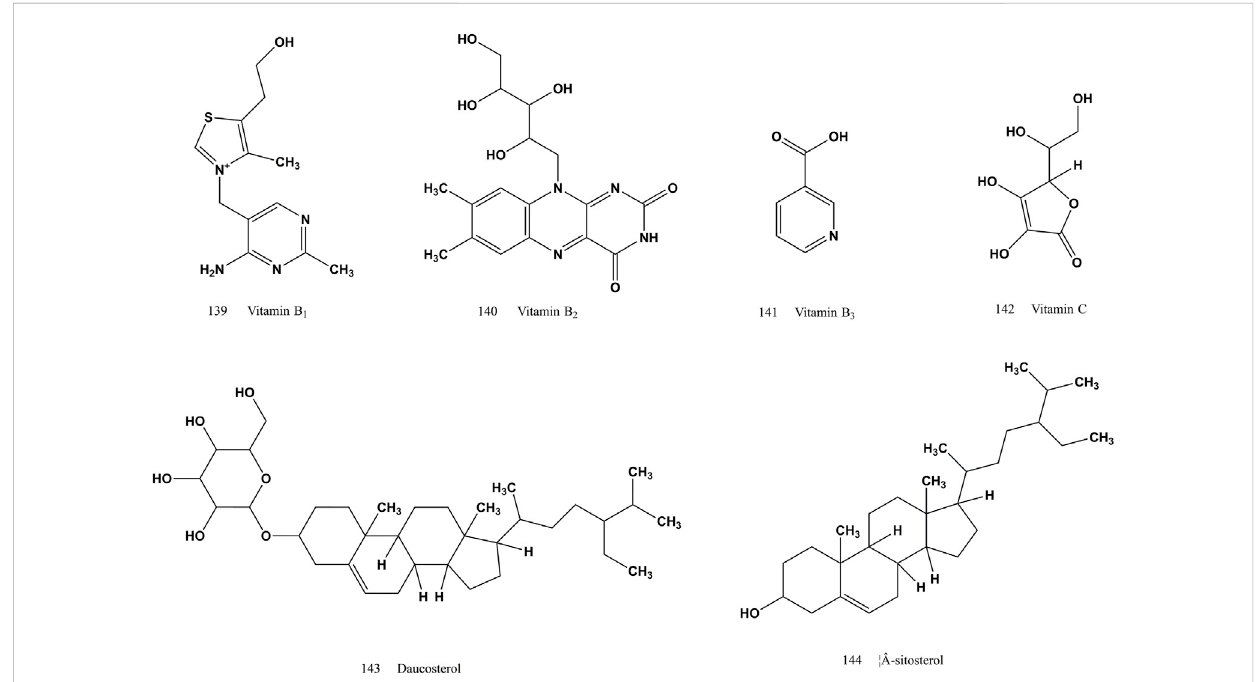
FIGURE 7 Chemical structures of vitamin and steroidal compounds identi fi ed from SS (compound 139 – 144